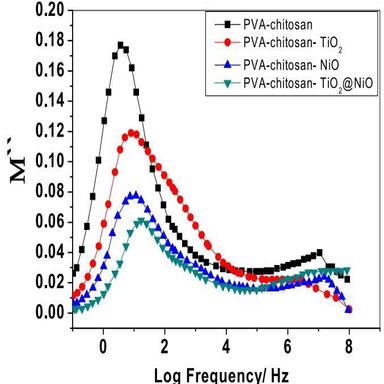
Variation in M″ with Log f for the PVA-chitosan–TiO2, PVA-chitosan–NiO, and PVA-chitosan– TiO2@ NiO films.